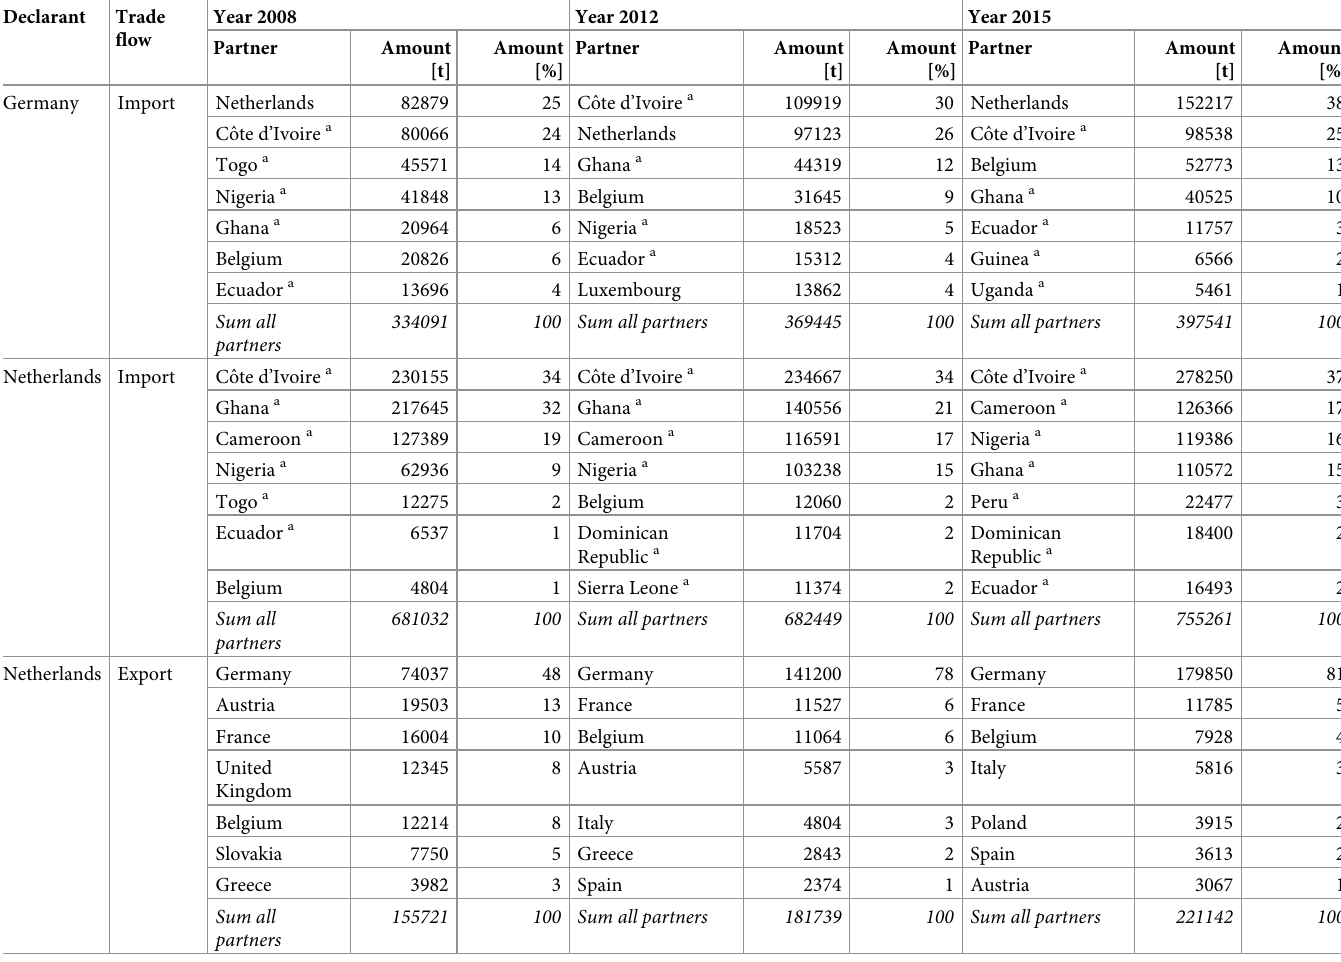
Table 5. Trade flows of cocoa beans for Germany and the Netherlands according to Eurostat in the years 2008, 2012 and 2015. Evaluations are based on the database Eurostat [38] using the software Warenstrom-Info [39]. HS code 18010000 “cocoa beans, whole or broken, raw or roasted” was considered. Declarant Trade